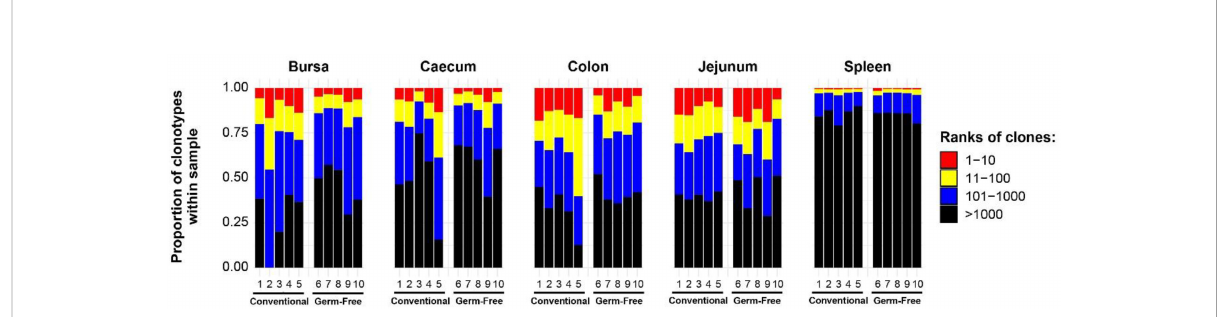
FIGURE 2 TCR b clonal homeostasis plots of individual tissue samples. Bird numbers and their corresponding microbial colonisation status are displayed on the x axis. Clones were ranked based on their abundance into four categories: fi rst 10 most abundant (red), from 11-100 (yellow), 101-1000 (blue), and above 1000 (black) in terms of total abundance within each sample. The proportions of clonotypes are displayed on the y